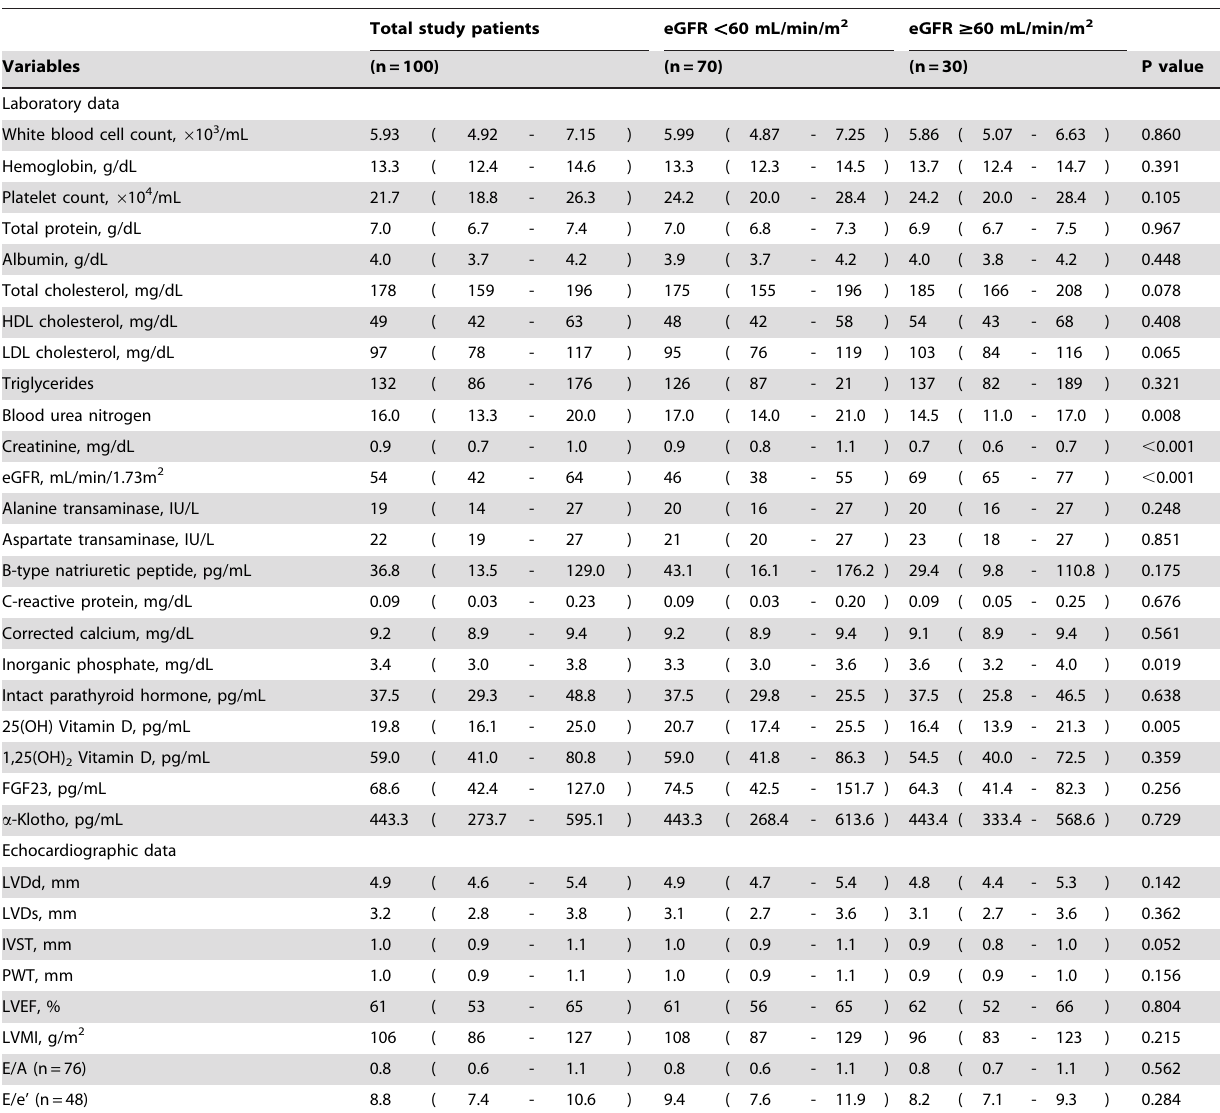
Table 2. Laboratory and echocardiographic